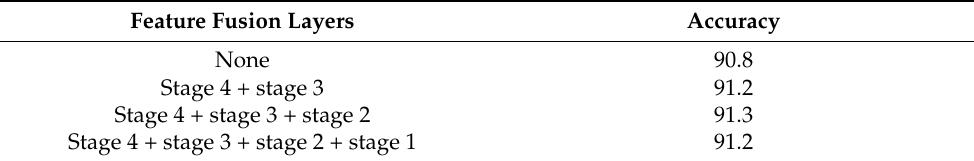
Table 3. Multilevel feature fusion ablation